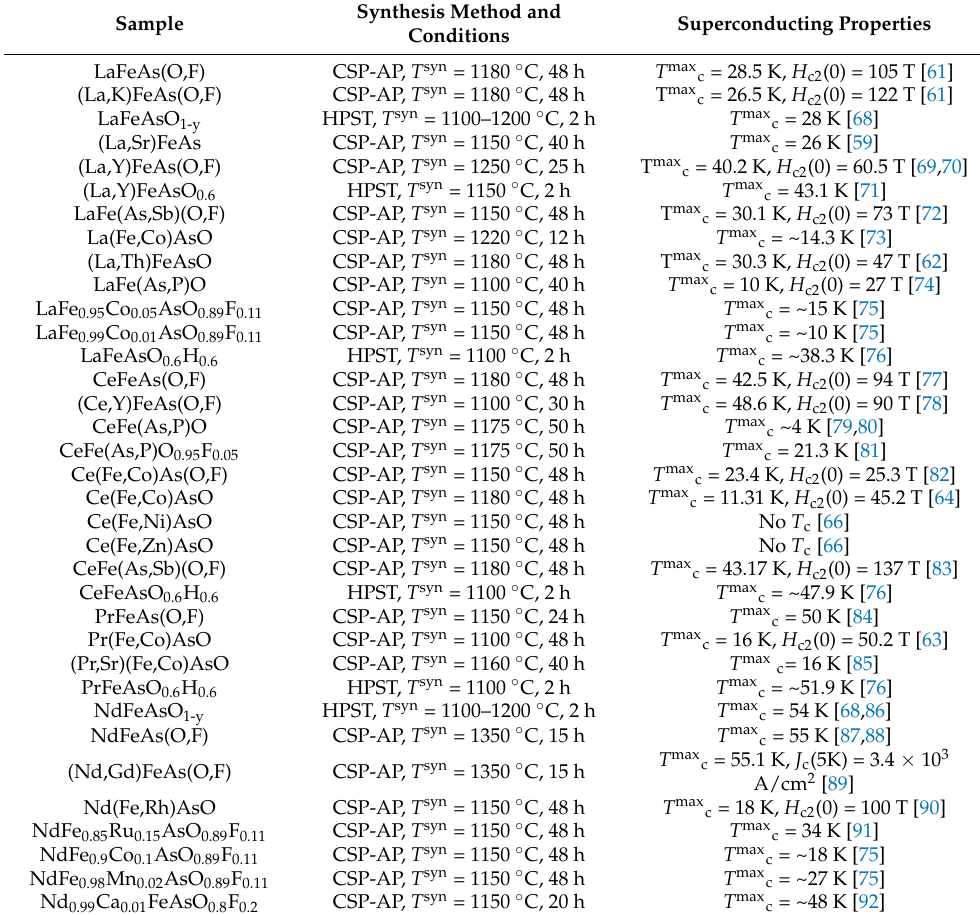
Table 1. A list of polycrystalline samples reported for the 1111 ( RE FeAsO) and 1144 ( AEA Fe 4 As 4 ) families, along with their synthesis conditions and superconducting properties. T syn is used for the synthesis temperature and heating time. The Solid-State Reaction (SSR) method at high pressure and ambient pressure is represented by the high-pressure synthesis technique (HPST) and the conventional synthesis process at ambient pressure (CSP-AP),